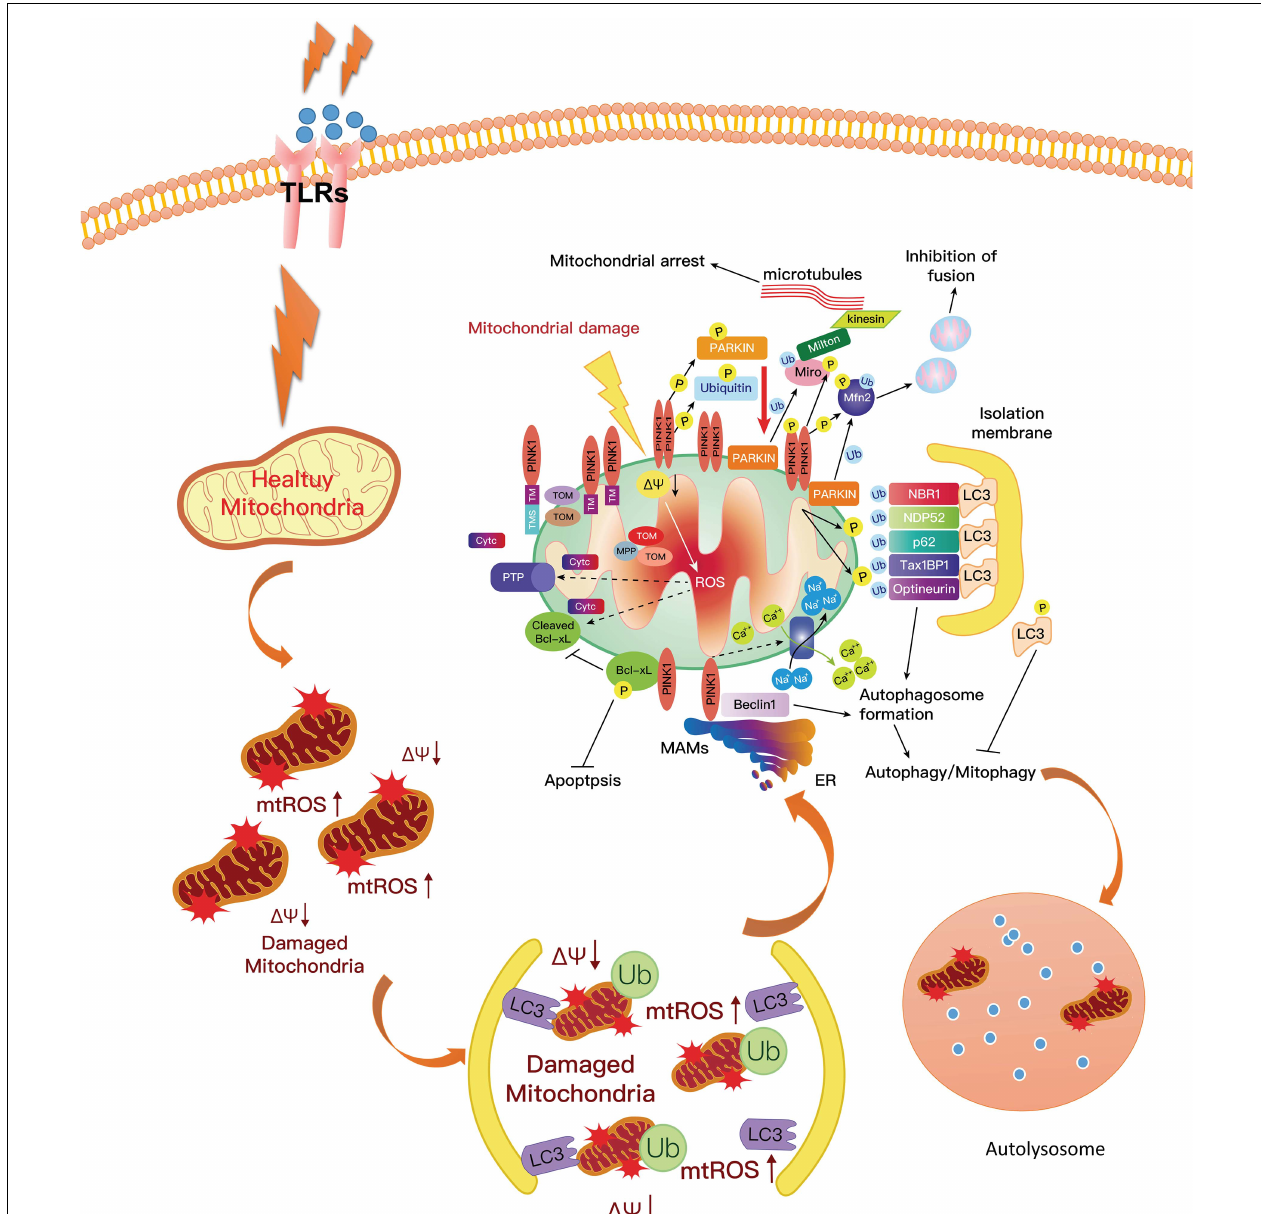
FIGURE 4 | PINK1 could phosphorylate Parkin on the mitochondrial surface, resulting in the activation of Parkin. The activated Parkin proteins form phospho-polyubiquitin chains on damaged mitochondria. Finally, the dysfunctional mitochondria are cleared via autophagy. In this way, mitophagy inhibits neuroinflammation in PD and increases microglial phagocytosis. However, the mutation of PINK1 or Parkin would alter the balance of fission to fusion by preventing cells from responding to mitochondrial damage. The expression of ROS and pro-inflammatory factors are increased, which aggravates the development of PD. PD, Parkinson’s disease; ROS, reactive oxygen